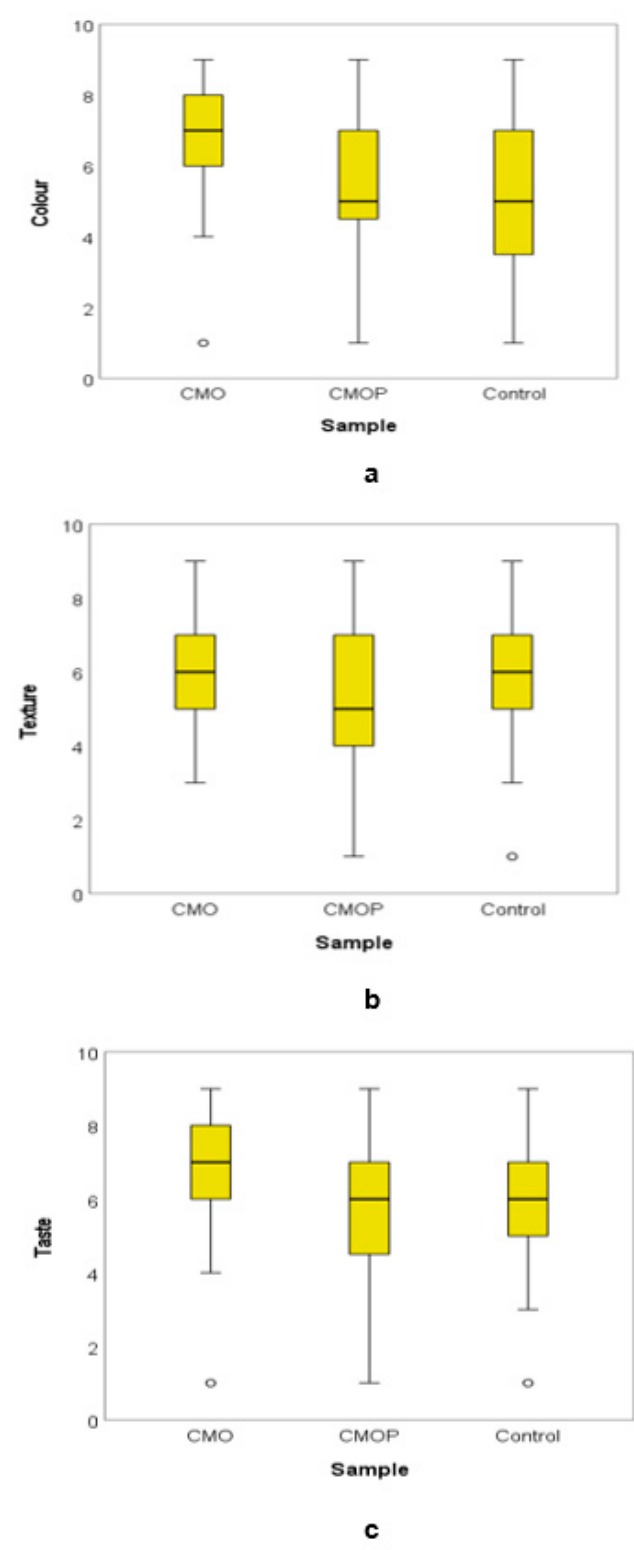
Figure 3. Mean value scores of acceptability: ( a ) colour, ( b ) texture and ( c ) taste scores for CMO (Citric acid + Moringa oleifera leaf extract powder), CMOP (Citric acid + Moringa oleifera leaf extract powder + potassium sorbate) and control dried sliced apples .